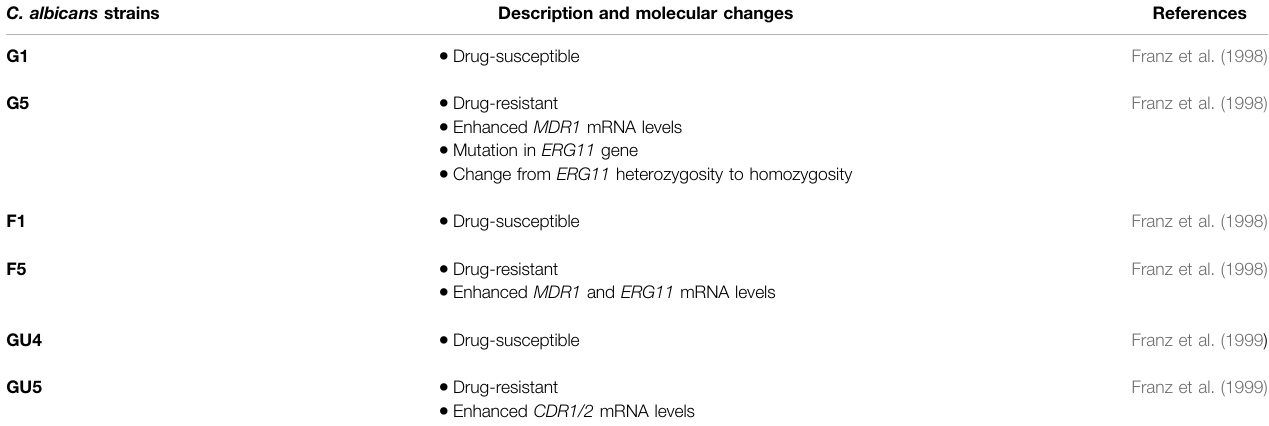
TABLE 1 | Description of C. albicans strains